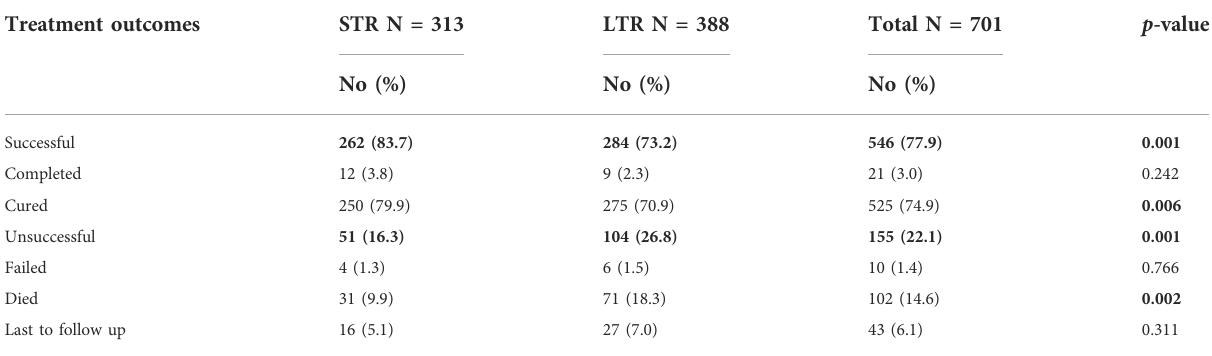
TABLE 3 Treatment outcomes of STR and